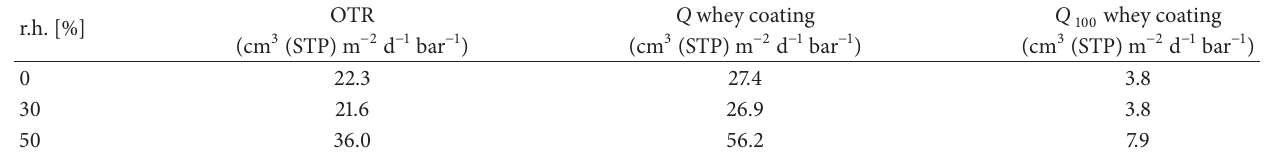
Table 3: OTR versus r.h. for whey-coated PET films (measured according to DIN 53 380, T3). r.h. [%]